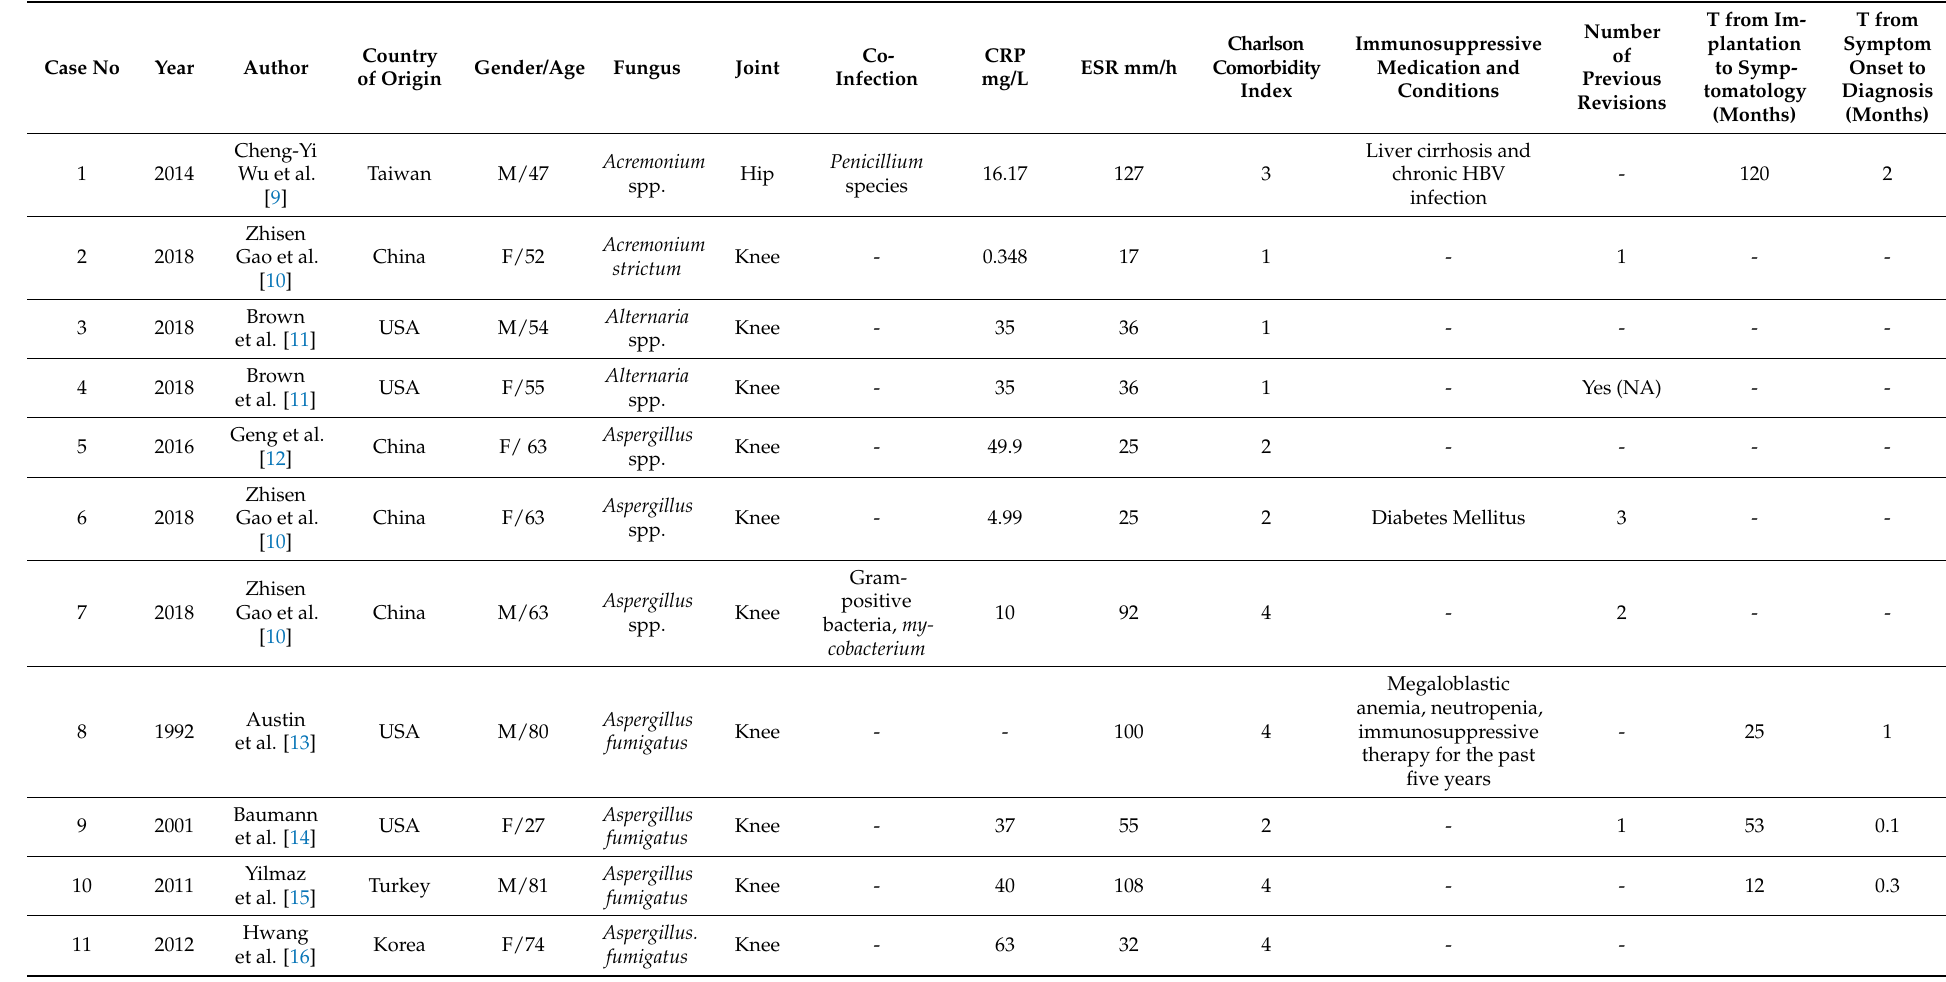
Table 1. Patients’ demographics, comorbidities, responsible fungus, affected joint, bacterial co-infection, time (T) intervals from joint implantation to symptom onset and from symptom to diagnosis, number of previous revisions in the same joint, C-reactive protein, (CRP), and erythrocyte sedimentation rate (ESR) at